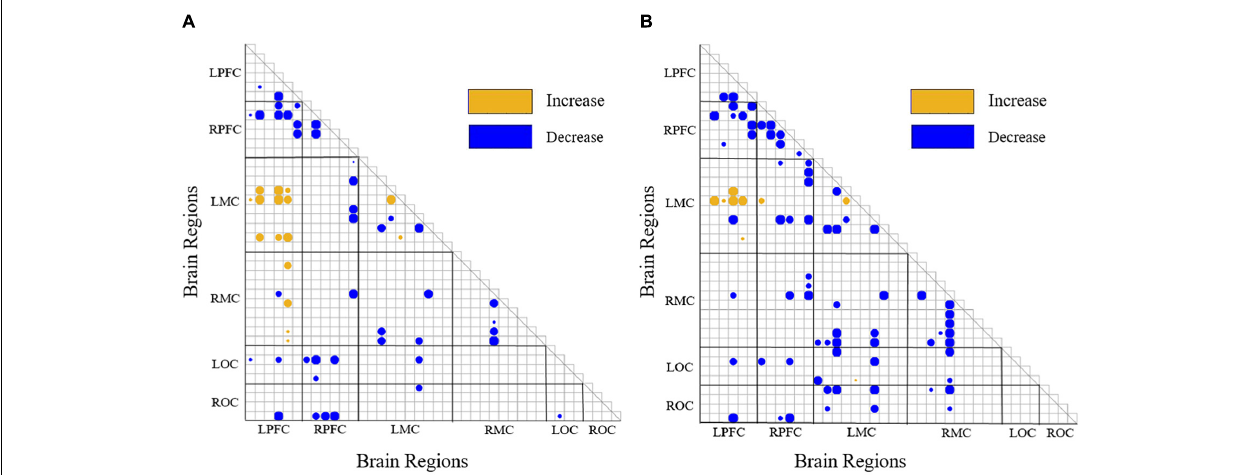
FIGURE 8 | Significance matrix of WPCO value change. yellow color suggested that there was a significant increase of WPCO value between two states ( p < 0.0167), blue color represented that there was a significant decrease of WPCO value between two states ( p < 0.0167). (A) The significance matrix of the change of WPCO value between each pair of channels of VR grasping movements compared with that of resting state. (B) The significance matrix of the change of WPCO value between each pair of channels of VR grasping movements compared with that of grasping movements.